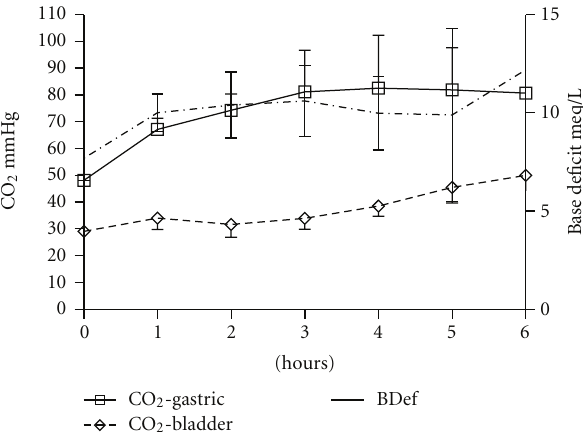
Figure 1: Changes of gastric and bladder mucosal CO 2 and base deficit for six hours after septic shock provocation.